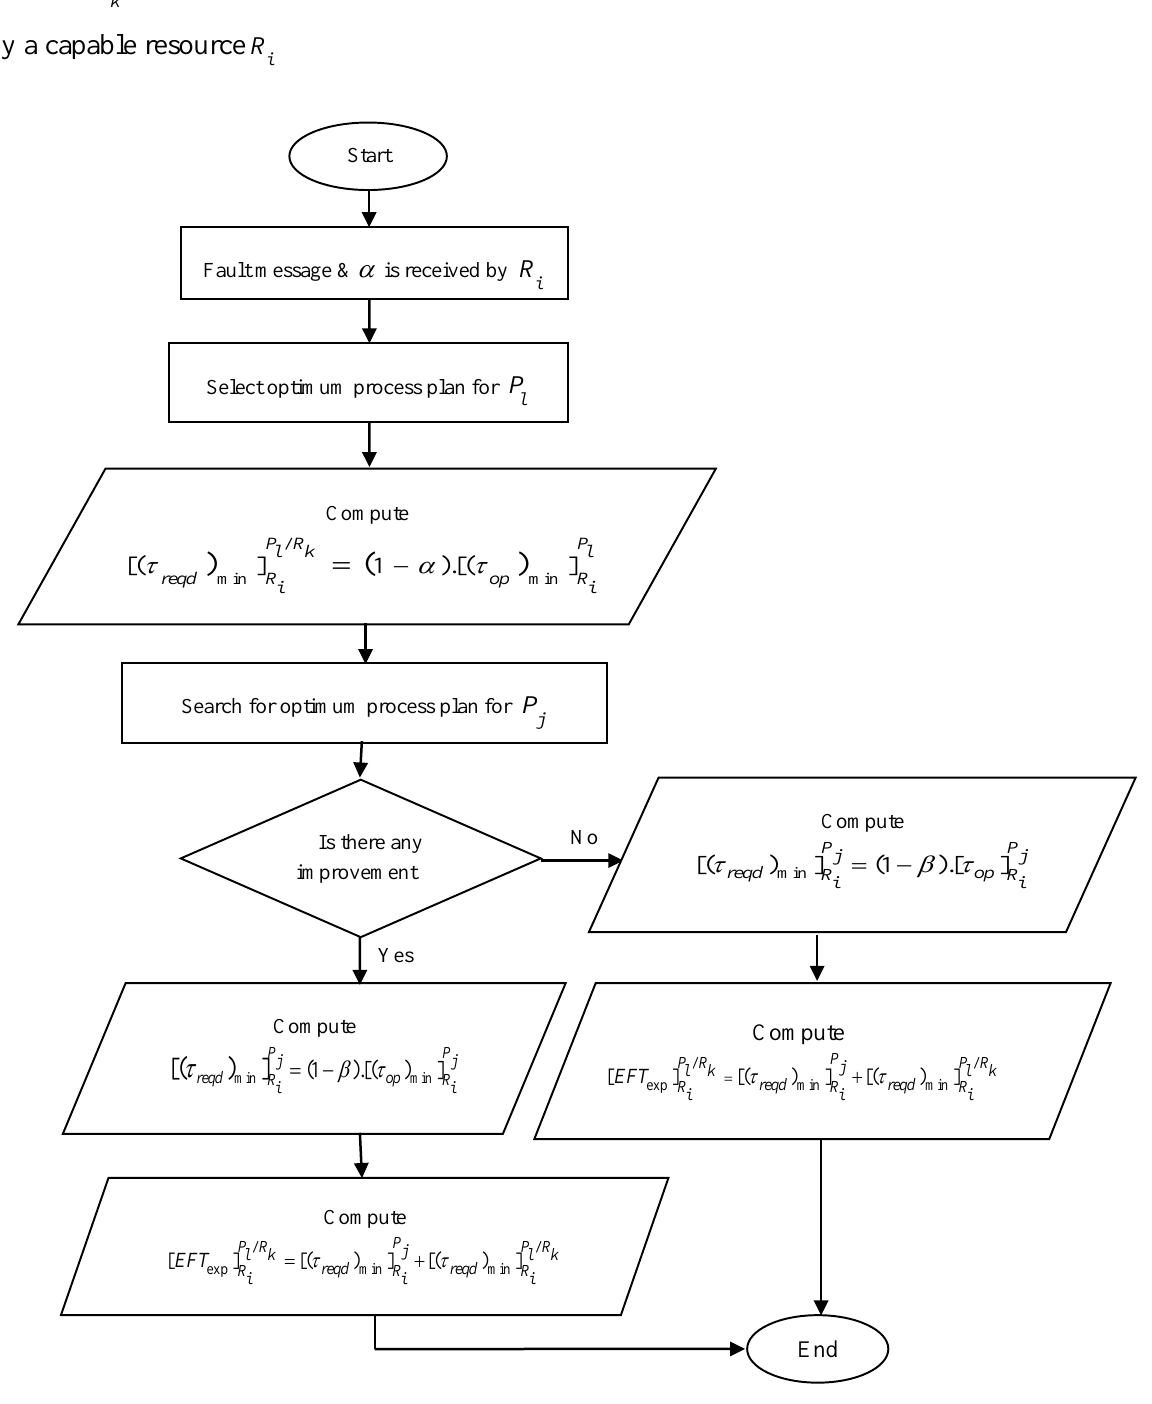
Fig. 4. Flowchart showing execution of the metamorphic